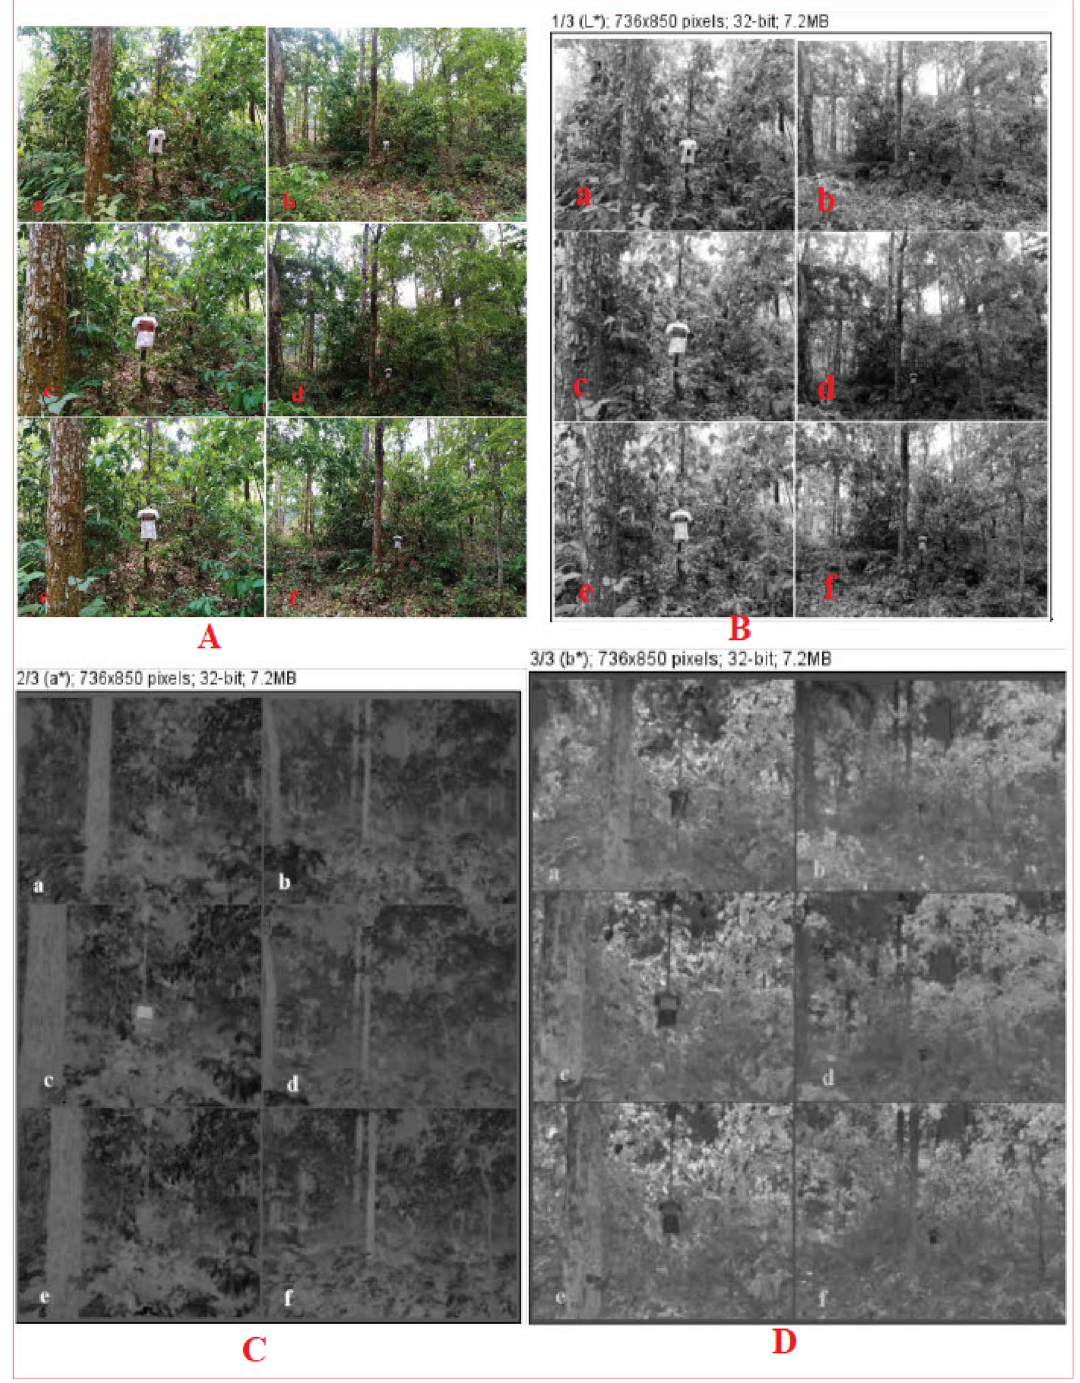
Figure 7. NPND-dyed-coated-printed garments placed against woodland CB; shown the photometric versus colorimetric views of CIE L* ( B ), a* ( C ), b* ( D ) in grey scale imaging of RGB raw image ( A ) when the pictorial mapping has been engendered as Aa = Ba = Ca = Da; Ab = Bb = Cb = Db; Ac = Bc = Cc = Dc; Ad = Bd = Cd = Dd; Ae = Be = Ce = De; Af = Bf = Cf = Df for chromatic Fig. 7Ba,Ca,Da,Bb,Cb,Db,Bc,Cc,Dc,Bd,Cd,Dd,Be,Ce,De,Bf,Cf,Df and compared with raw image of target sig- nature against Shorea Robusta Gaertn , woodland CB shown in Fig. 7Aa,Ab,Ac,Ad,Ae,Af. Similarly Fig. 8A; raw image of NPND-dyed-coated-printed garments have been positioned against Shorea Robusta Gaertn , woodland CB; and RGB chromatic hues have been represented as blue color shown in Fig. 8B, green color shown in Fig. 8C and red color shown in Fig. 8B when Aa = Ba = Ca = Da; Ab = Bb = Cb = Db; Ac = Bc = Cc = Dc; Ad = Bd = Cd = Dd; Ae = Be = Ce = De; Af = Bf = Cf = Df shown in Fig. 8. White-black/grey scale breakdown of RGB chromatic hue